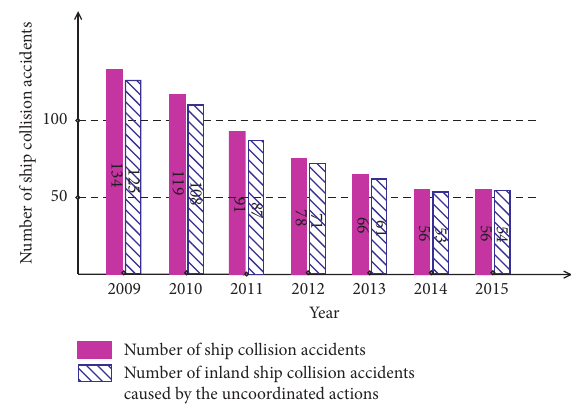
Figure 1: Statistics of inland ship collision accidents from 2009 to